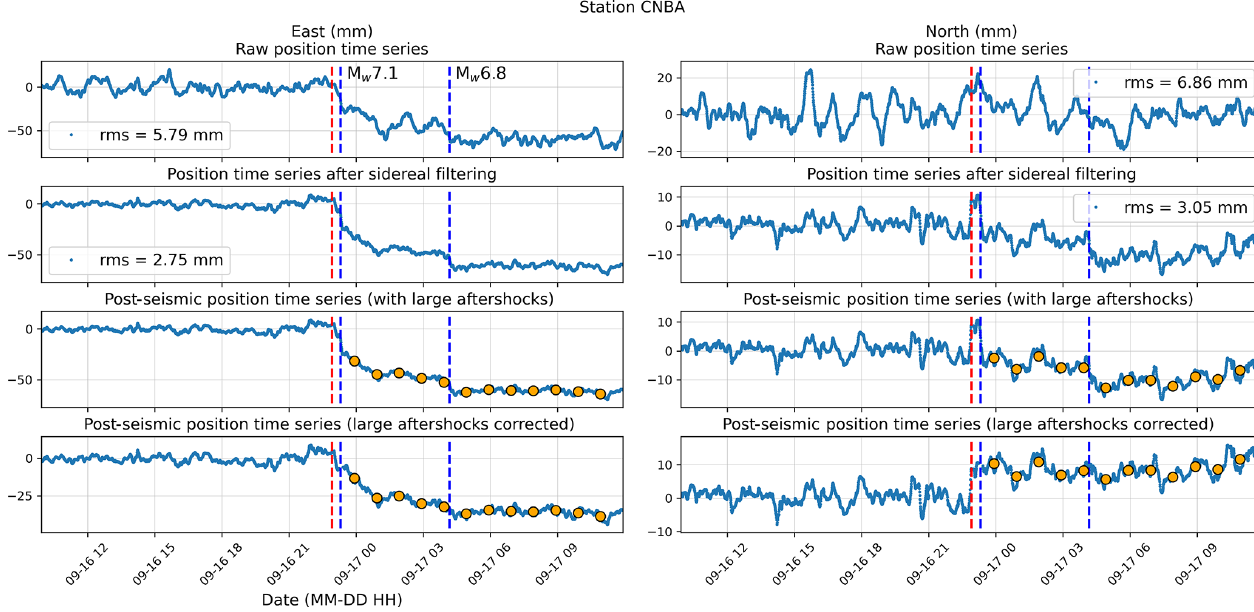
Figure 2. Processing steps performed to get the time series used in this study. The first row shows the raw position time series. The mean and a linear trend are calculated using the 6d prior to the mainshock origin time (red dashed line) and are removed from the time series. We also calculated the root mean square (rms) over that same time period to illustrate the noise level. Note that the static offset of the mainshock is removed. The second row shows the position time series after applying a sidereal filter which is constructed as proposed by Twardzik et al. (2019). This allows the noise level to be reduced by ∼ 35% across all stations. The third row shows the position time series that we use to obtain the spatiotemporal evolution of the post-seismic slip over the first 12h (orange dots). Each dot is the average position using a 1h time window centered on the time of interest and spanning 30min on either side. The fourth row shows the position time series with the estimated static offsets of the two largest aftershocks removed. In all figures, the blue dashed lines show the two largest aftershocks in the GCMT catalog. Supplement S2 shows a similar figure for all the